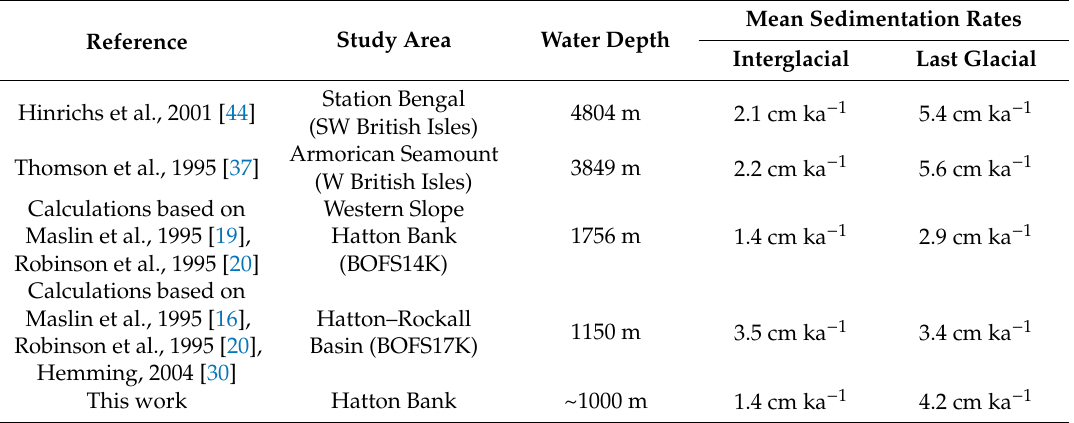
Table 4. Sedimentation rates calculated for the NE Atlantic.